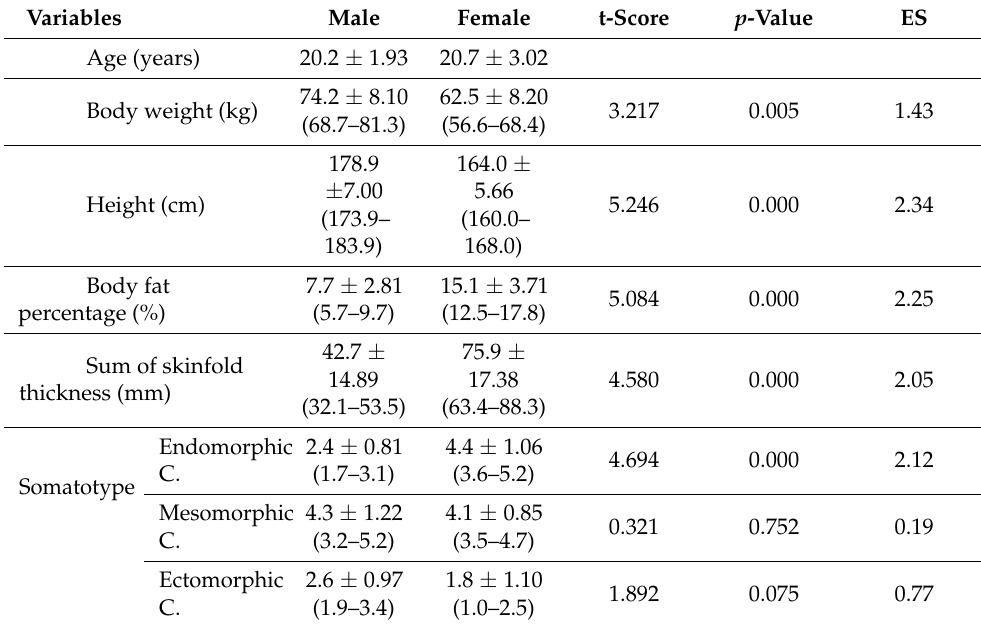
Table 1. Anthropometric and somatotype of collegiate water skiers (Mean ± Standard Deviation).